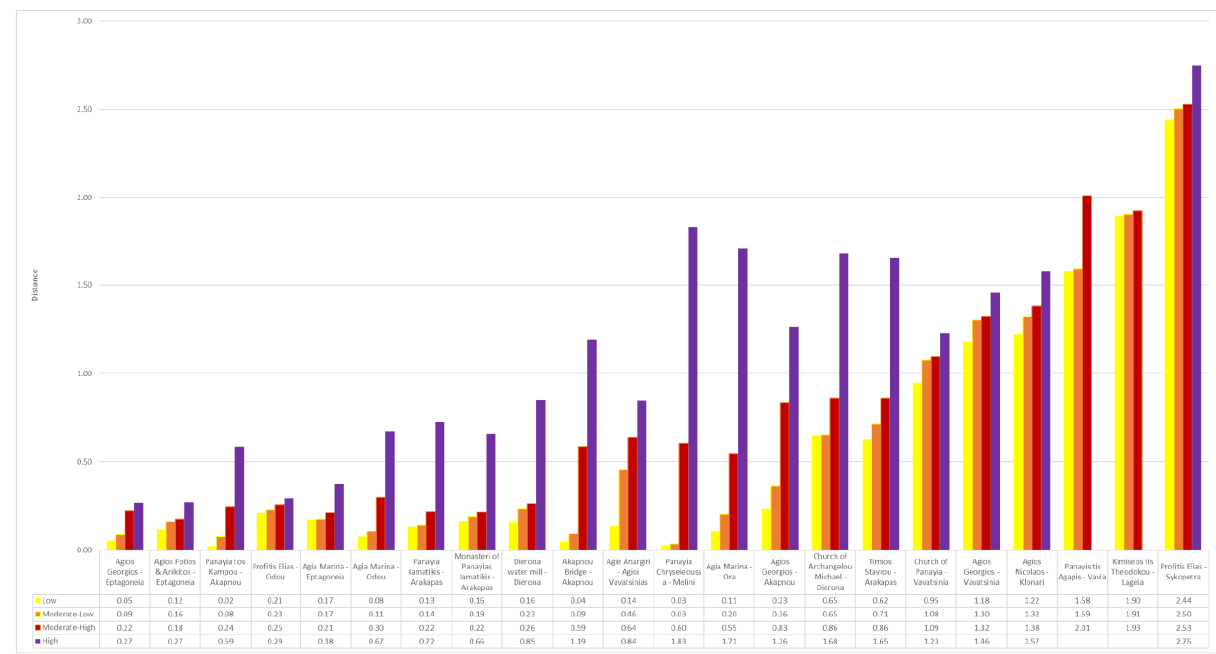
Figure 11 CH distance from the severity